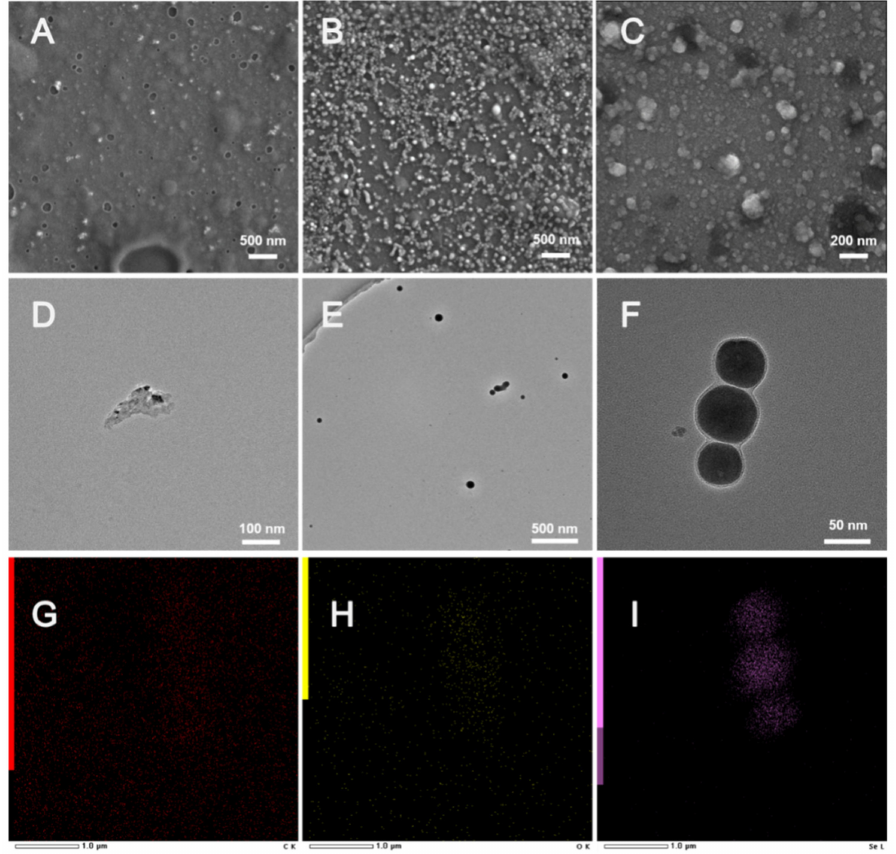
Figure 1. SEM images of ( A ) SM, ( B ) SM-SeNPs, and ( C ) SM-EGCG-SeNPs. TEM images of ( D ) SM, ( E ) SM-SeNPs, and ( F ) SM-EGCG-SeNPs. EDS elemental mapping of ( G ) C, ( H ) O, and ( I )